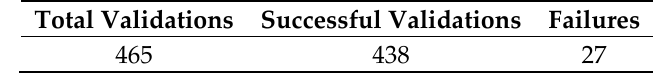
Table 1. Quality evaluation of the test performed.